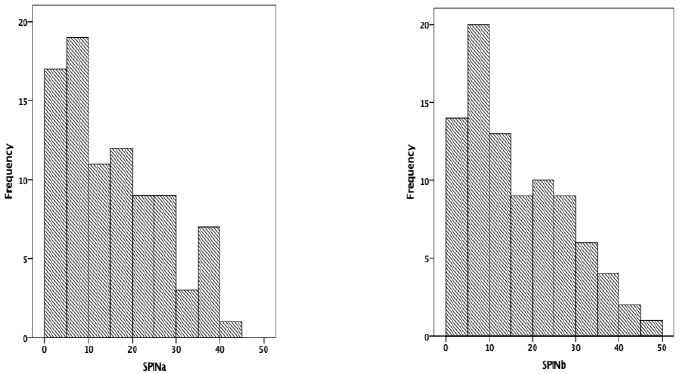
Figure 6. The test–retest assessment of the SPIN (SPINa—initial evaluation; SPINb—follow-up Figure 6. The test – retest assessment of the SPIN (SPINa — initial evaluation; SPINb — follow-up eval- uation).